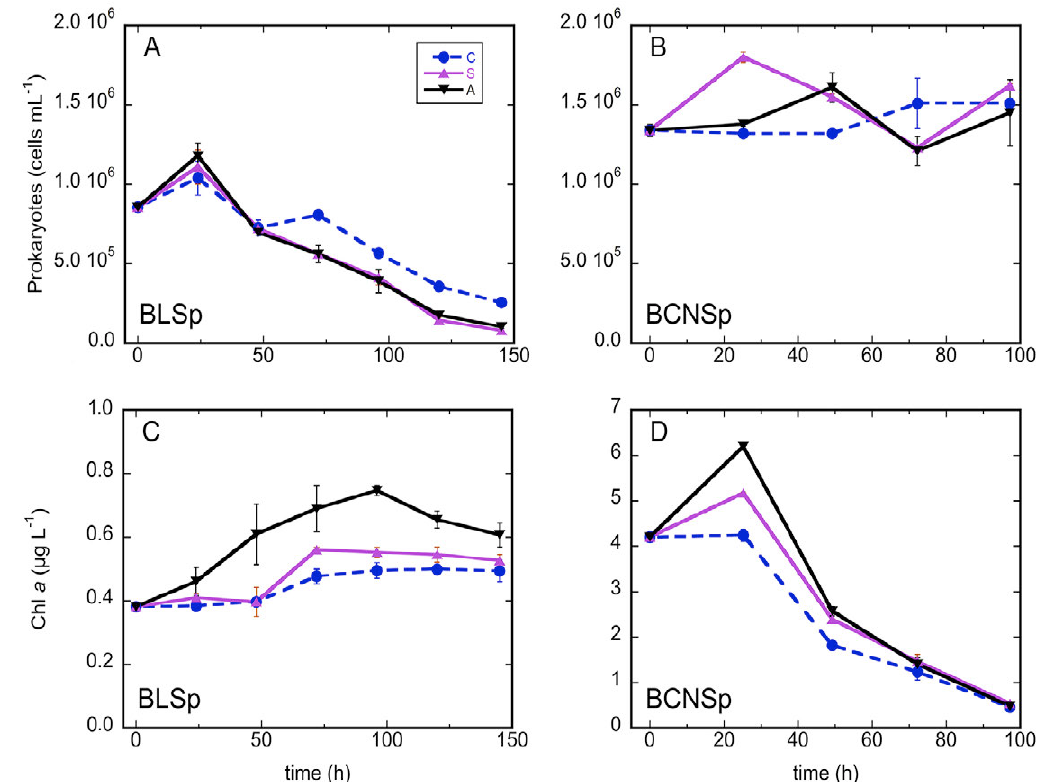
Fig. 2. – Heterotrophic prokaryotic abundance over time for the three treatments of BLSp (A) and BCNSp (B) experiments. Aerosols were added at t=4 h in both